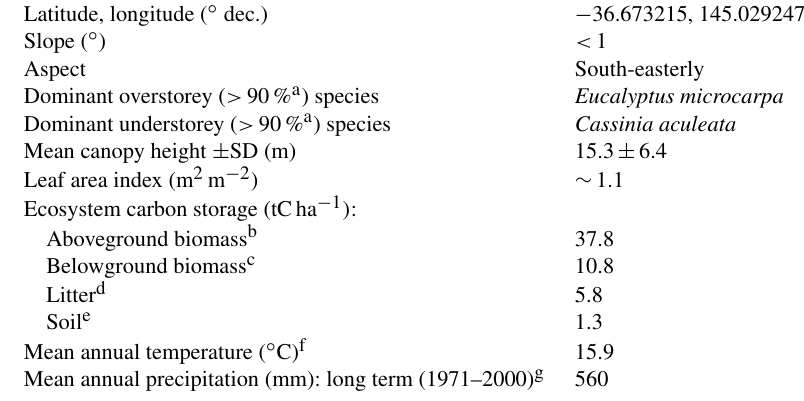
Table 1. Site characteristics.